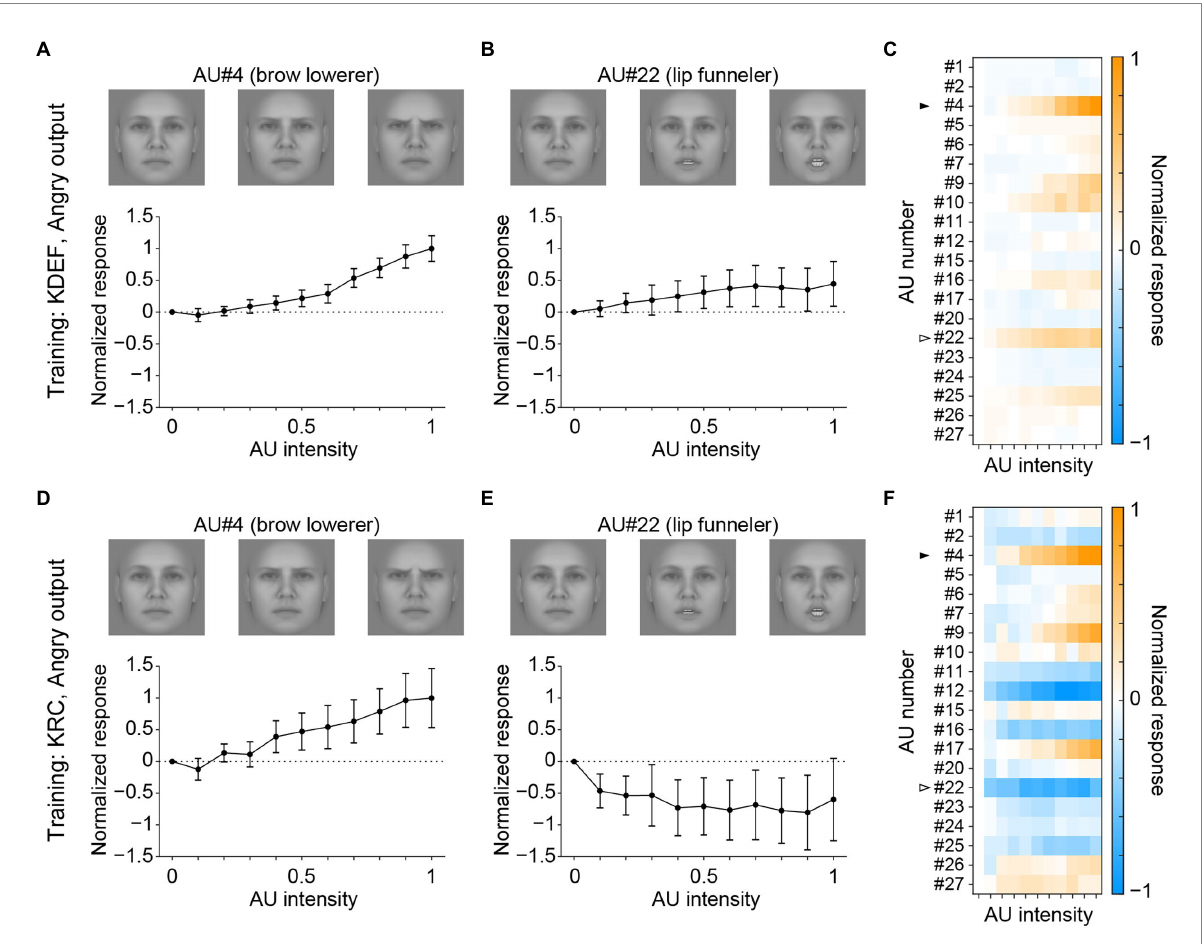
FIGURE 6 Selectivity of the outputs of the “angry” unit in the FC3 layer to the AUs. Tuning curves of the “angry” unit of the KDEF-trained CNNs for AU#4 ( A , brow lowerer) and AU#22 ( B , lip funneler), and the response profiles of the KDEF-trained CNNs (C) are shown. Lower panels (D–F) show the response profiles of the “angry” unit of the KRC-trained CNNs. The conventions are the same as in Figure